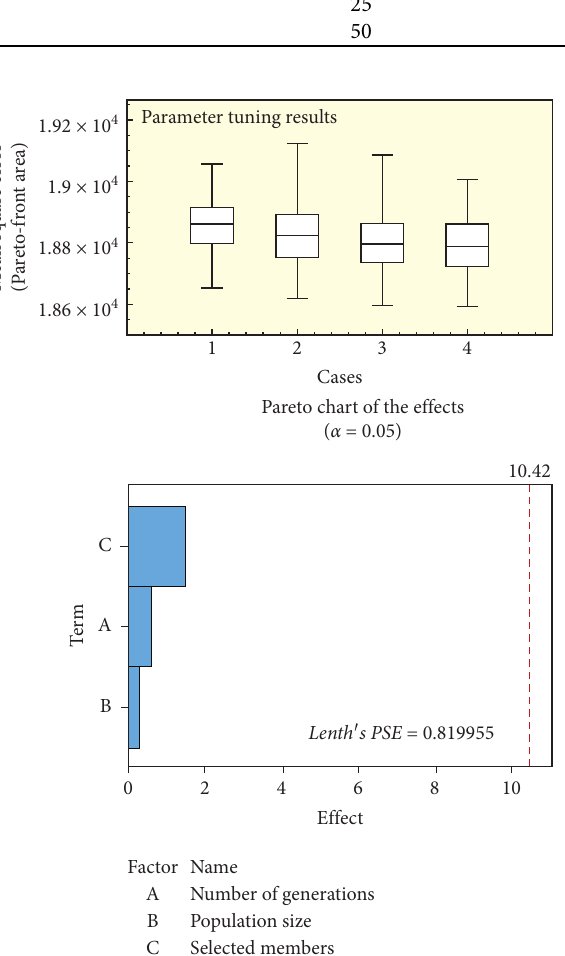
Figure 18: Parameter